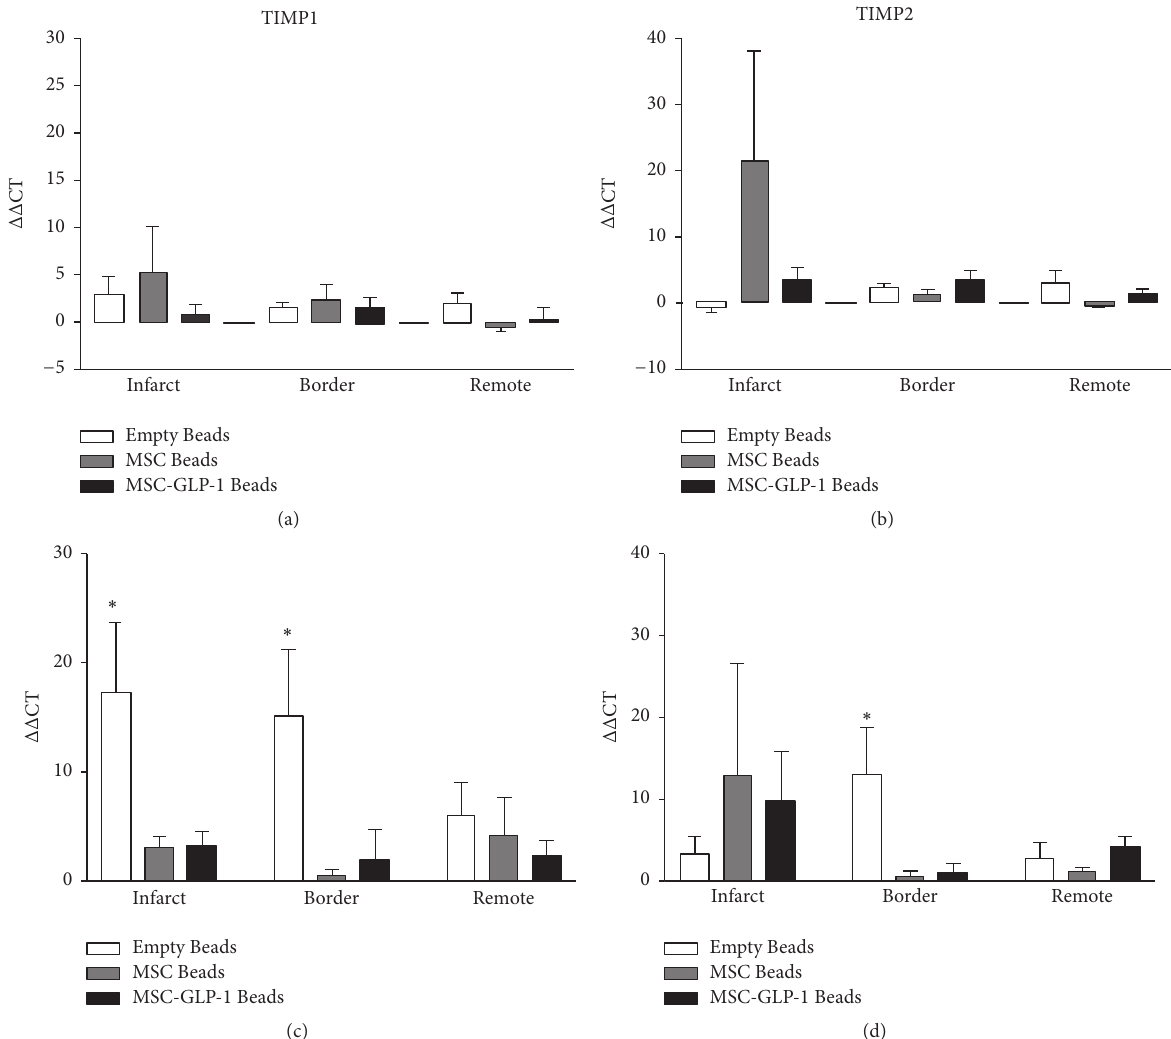
Figure 3: Quantification of TIMP1 and TIMP2 mRNA levels. (a) One week after MI, small increases in TIMP1 mRNA levels were observed. (c) After four weeks, significant increases were seen in both infarct and border regions of the Empty Bead group. (b) After one week, no significant differences were observed in TIMP2 mRNA levels; however four weeks after MI, significantly more mRNA was detected in the infarct and border zone of the Beads group (d). 𝑁 = 3 – 5 per group; 𝑃 < 0.05